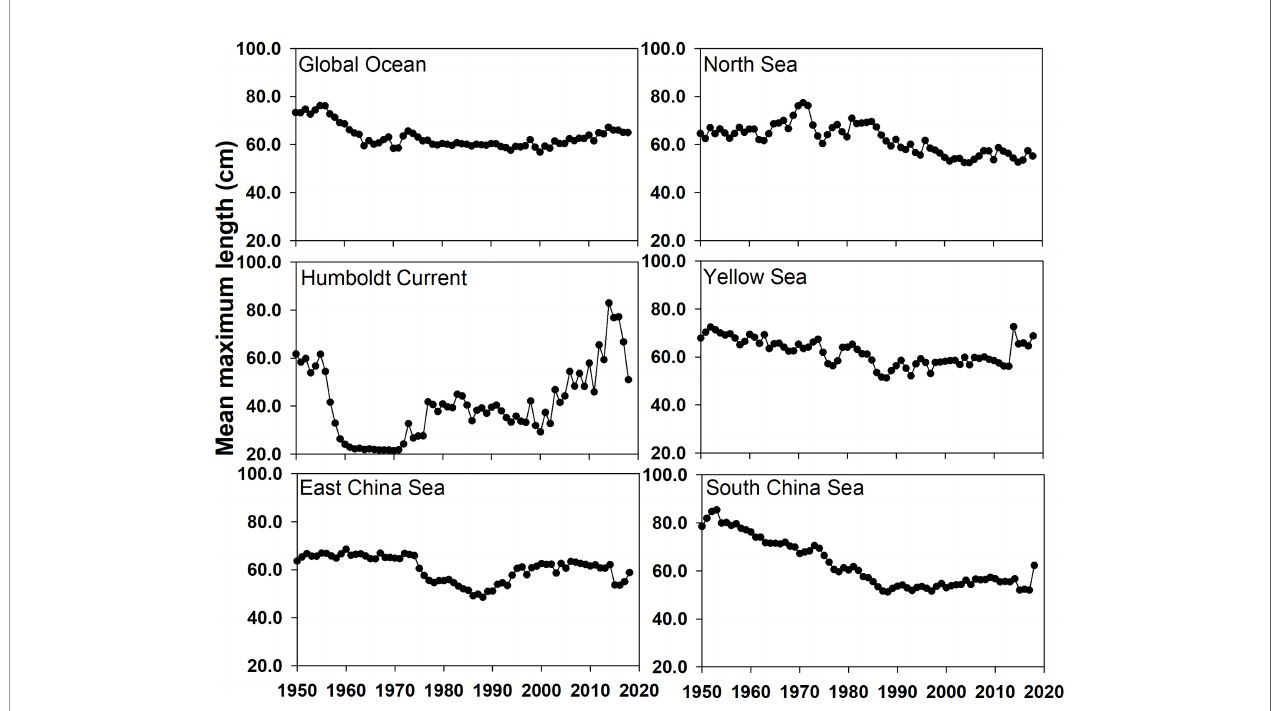
FIGURE 5 | Mean maximum length of fi sheries catch in the global ocean and fi ve LMEs from 1950 to